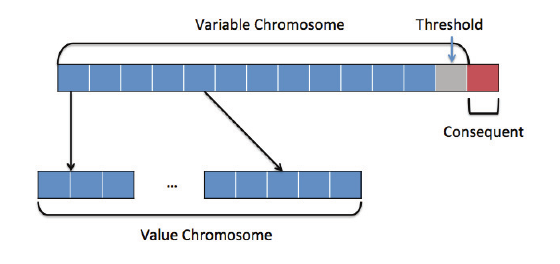
Fig. 7. Representation of a population individual in